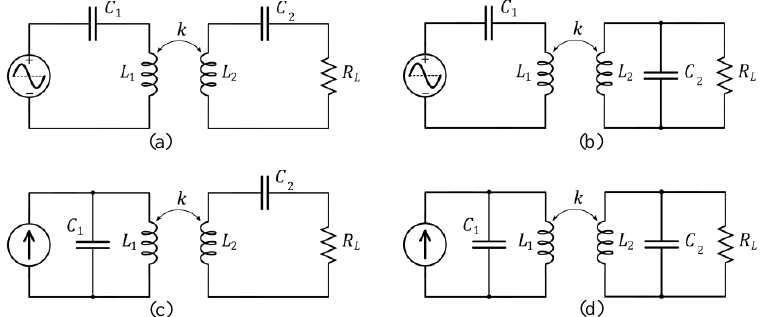
Figure 13. Summary of basic circuit compensation topologies used in IWPT configurations: ( a ) serial-serial (SS); ( b ) serial-parallel (SP); ( c ) parallel-series (PS); ( d ) parallel-parallel (PP).